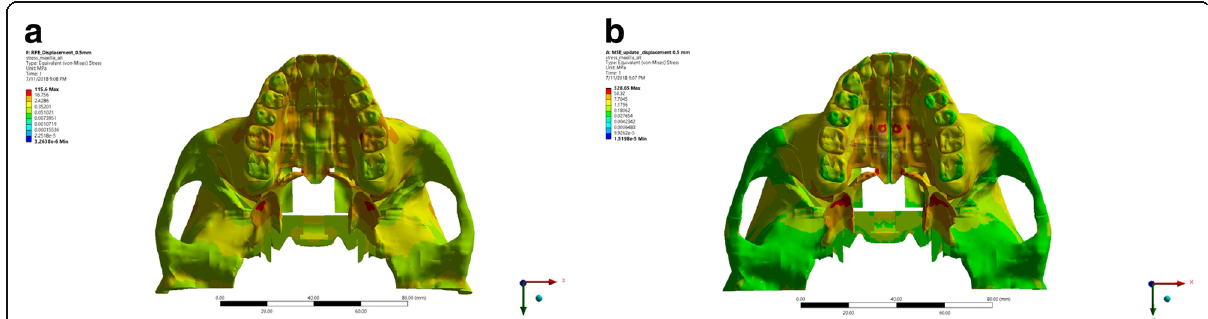
Fig. 9 Occlusal aspect of stress distribution as the result of expansion of RME ( a ) and MSE ( b